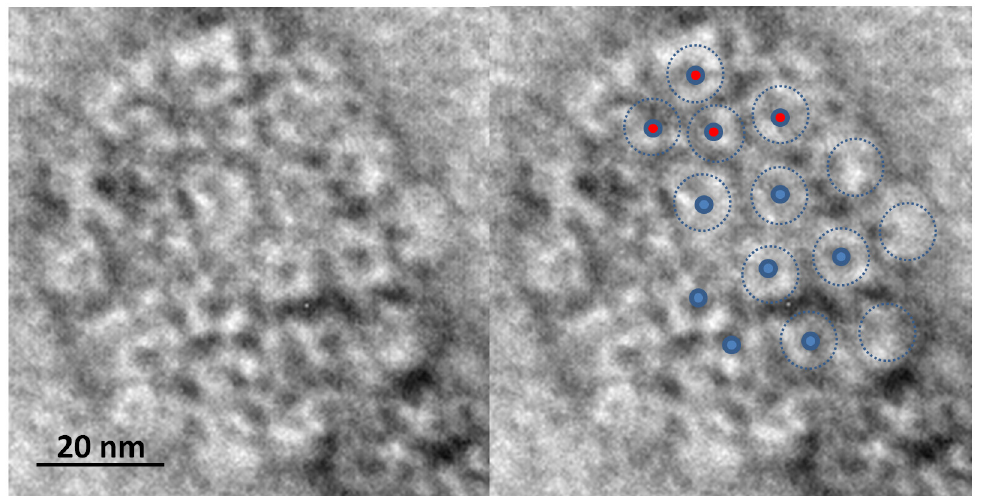
Fig 4. Capsomeres ’ 5- fold and 6-fold symmetry of a virus-like particle. A HPV16 VLP at the final state of the stabilization process (48 hours). The dots and dotted circles on the image at the right indicate the positions of the different groups of capsomeres with either a 5-fold or 6-fold symmetry. The size of the particle is * 60 nm.